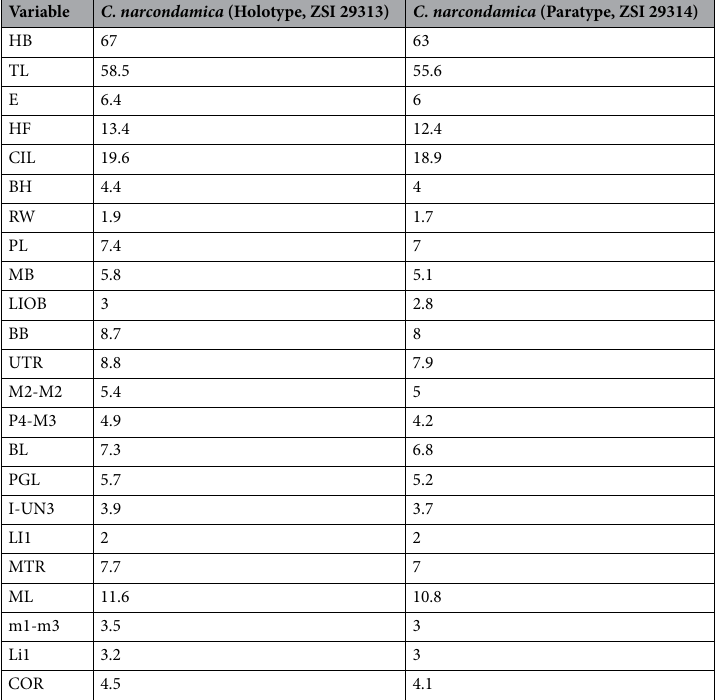
Table 1. External and craniodental measurements of the examined specimens of C. narcondamica (holotype and paratype) from Narcondam Island, India. For trait abbreviations (columns) see “Materials and methods” section. All measurements are in millimetres (n =